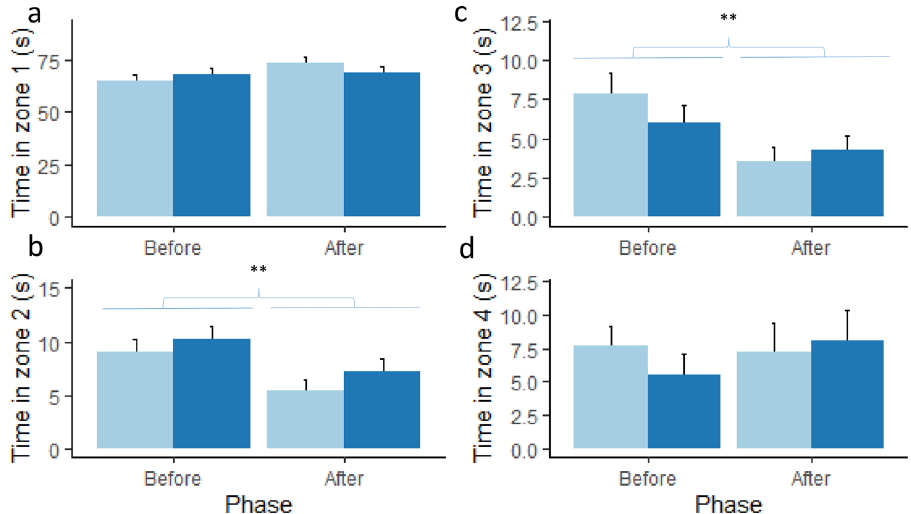
Figure 3. Mean ± sem duration of time spent in ( a ) Zone 1 (area near conspecifics), ( b ) Zone 2 (middle area), ( c ) Zone 3 (middle area) and ( d ) zone 4 (area with substrate and toys) for the control (light blue bars) and probiotic supplemented (dark blue bars) piglets before and after the threat. ** p < 0.01.